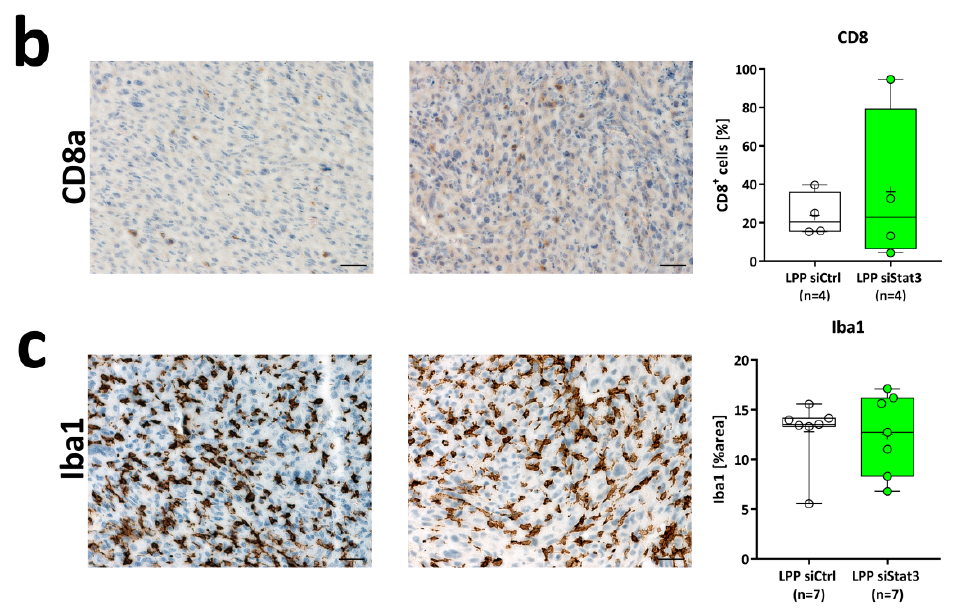
Figure 6. ( a – c ) Immunohistochemical analysis of ( a ) CD4, ( b ) CD8a and ( c ) Iba1 expressing tumor cells 21 days after implantation and treatment with LPP siCtrl and LPP siStat3. One representative picture is shown for each staining and treatment and the quantification is presented as box-plots (min-to-max) with all samples displayed as circles; the horizontal line in the box depicts the median value, the plus-symbol the mean value. scale bar: 200 µm.